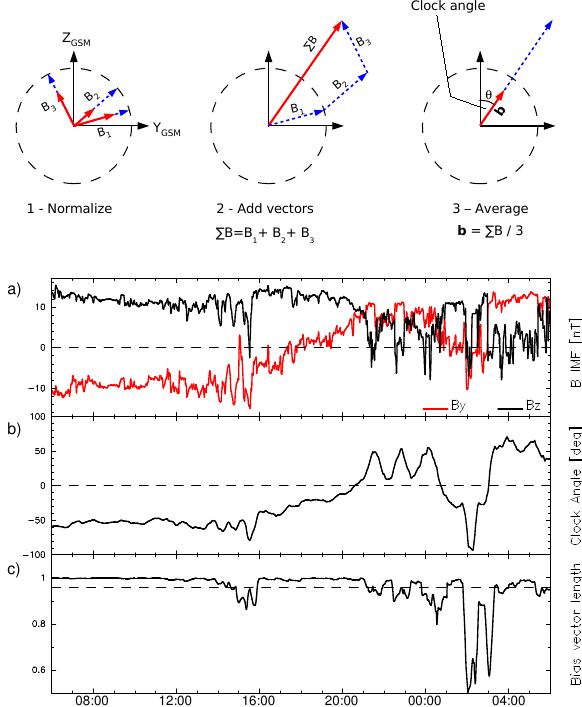
Fig. 3. Top: Illustration of the construction of the bias vector, b , used Fig. 3. Top : Illustration of the construction of the bias vector, b , used for IMF stability filtering. Bottom, panel for IMF stability filtering. Bottom, panel (a) : time shifted IMF B y (red) and B z (black) for 25 March, 2002; panel (b) : the resulting a): time shifted IMF B y (red) and B z (black) for 25 March, 2002; panel b): the resulting clock angle; panel c): clock angle; panel (c) : the bias vector magnitude, on which we base the bias vector magnitude, on which we base out IMF stability filtering, using a threshold of 0.96 (dashed line). out IMF stability filtering, using a threshold of 0.96 (dashed